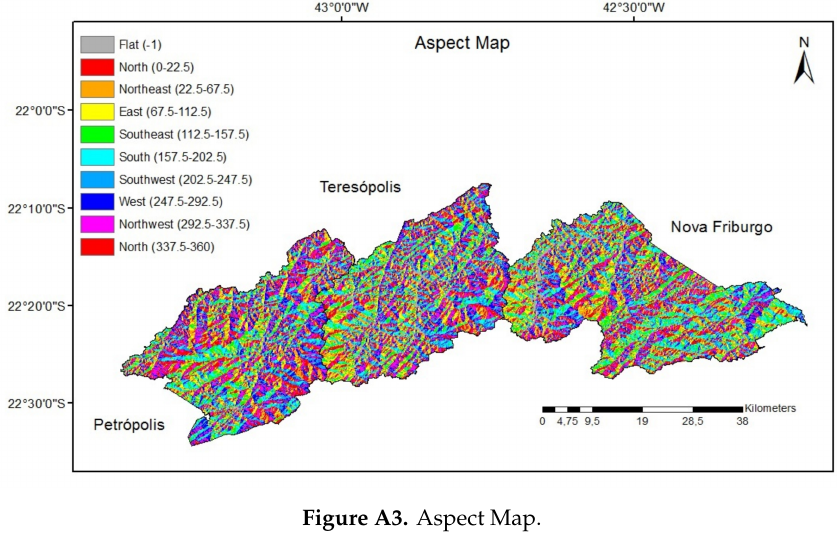
Figure A3. Aspect Map.